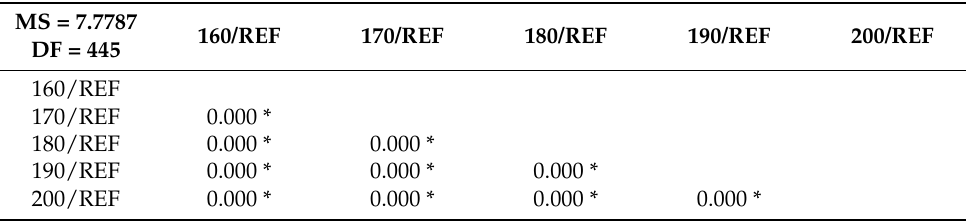
Table A3. Duncan’s multiple range test for changes in thermal conductivity.